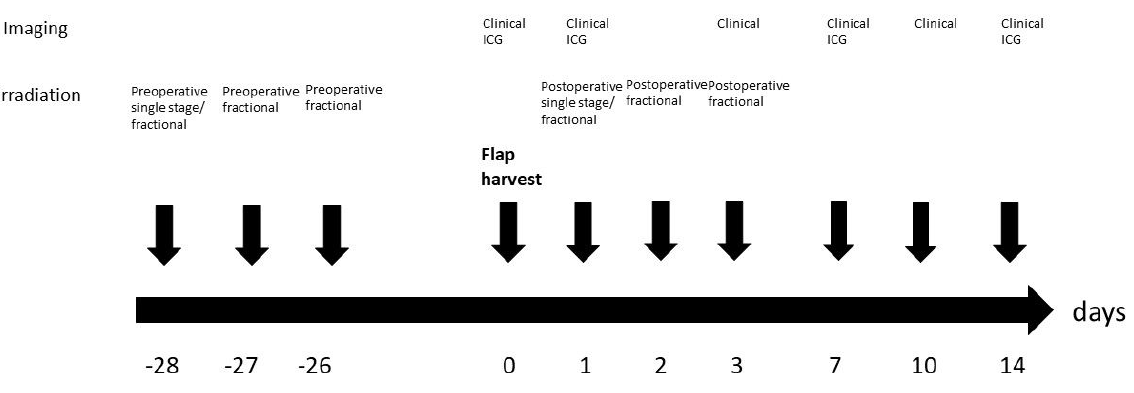
Figure 3. Study protocol. Figure 3. Study Figure 2. Irradiation procedure: ( A ) rat positioned for irradiation; ( B ) irradiated area.